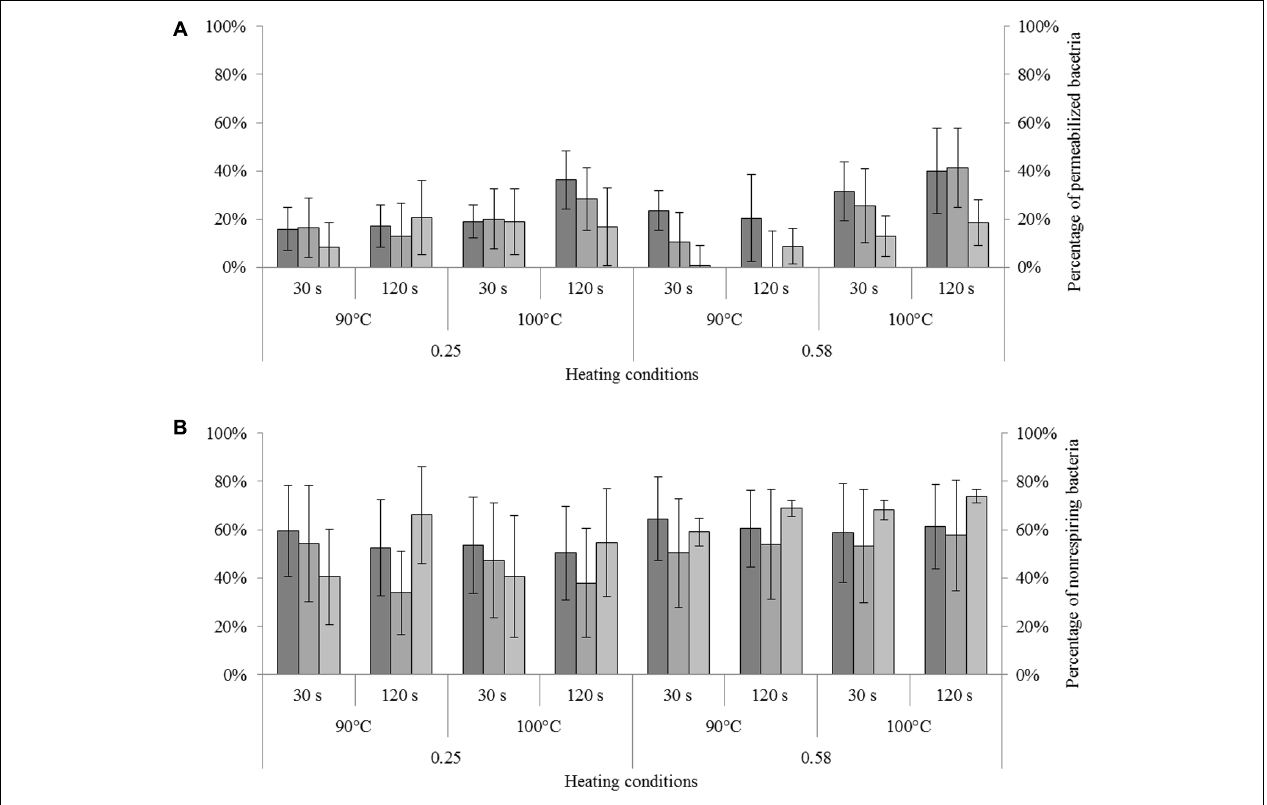
FIGURE 5 | Impact of heating in dried state on permeability and respiratory activity of Cronobacter sakazakii , Salmonella Typhimurium, and Salmonella Senftenberg cells. The number of unculturable cells was adjusted to 100% (presented on the left). (A) Impact of heating on membrane permeability of each species reported as a percentage of unculturable cells. From darker to lighter, the bars represent the percentages of permeabilized C. sakazakii , S. Typhimurium, and S. Senftenberg cells (right axis). (B) Impact of heating on respiratory activity of each species reported as a percentage of unculturable cells. From darker to lighter, bars represent the percentages of non-respiring C. sakazakii , S. Typhimurium, and S. Senftenberg cells (right axis). Error bars represent the standard deviation obtained using independent triplicates.